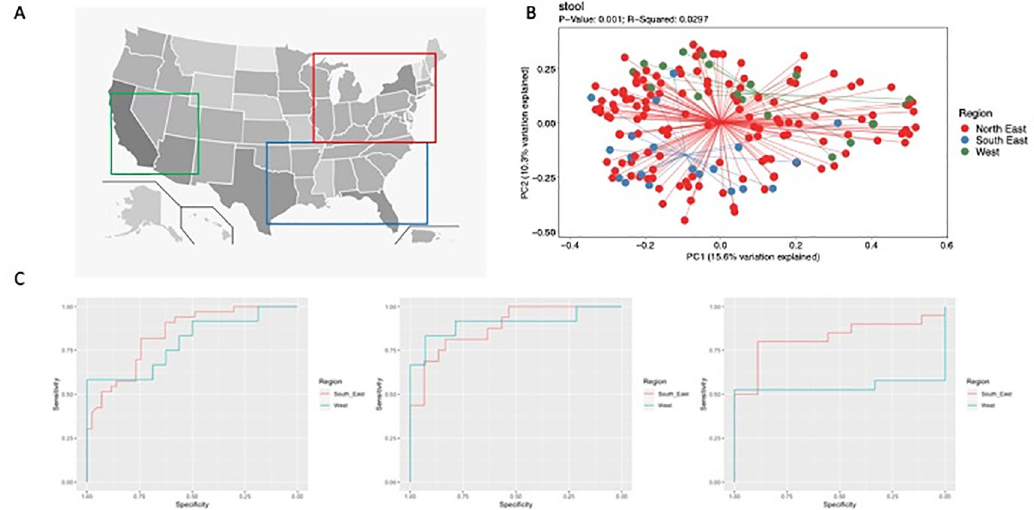
Figure 1. A) Map of the United States with squares indicating the arbitrarily defined North East (Red), South East(Blue)andWest(Green)regions,B)PrincipalComponentAnalysisofweightedBrayCurtismetricforfeces from patients with CD by region (PERMANOVA), C) Receiver operating characteristic (ROC) curves for a CD predictionmodeltrainedusingNorthEastdataandtestedonSouthEastandWestdataforileum,rectumand feces, from left to